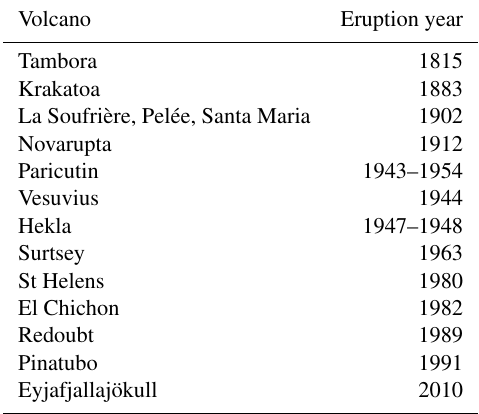
Table 5. Some of the major eruptions from the 1800s to the present day. These are defined as those eruptions having had either a Vol- canic Explosivity Index (VEI) greater than three, and having oc- curred in the Northern Hemisphere, where the majority of the au- thors of the considered poems lived, or having had a global im- pact and resonance. Data taken from the Global Volcanism Program (Venzke,